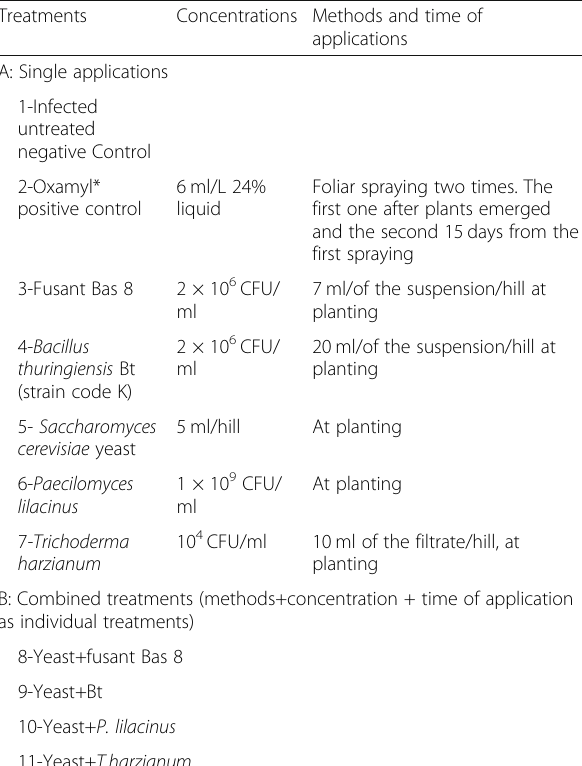
Table 1 Treatments designed for controlling root-knot nematode, Meloidogyne javanica , infecting peanut plant cv.6 under field conditions